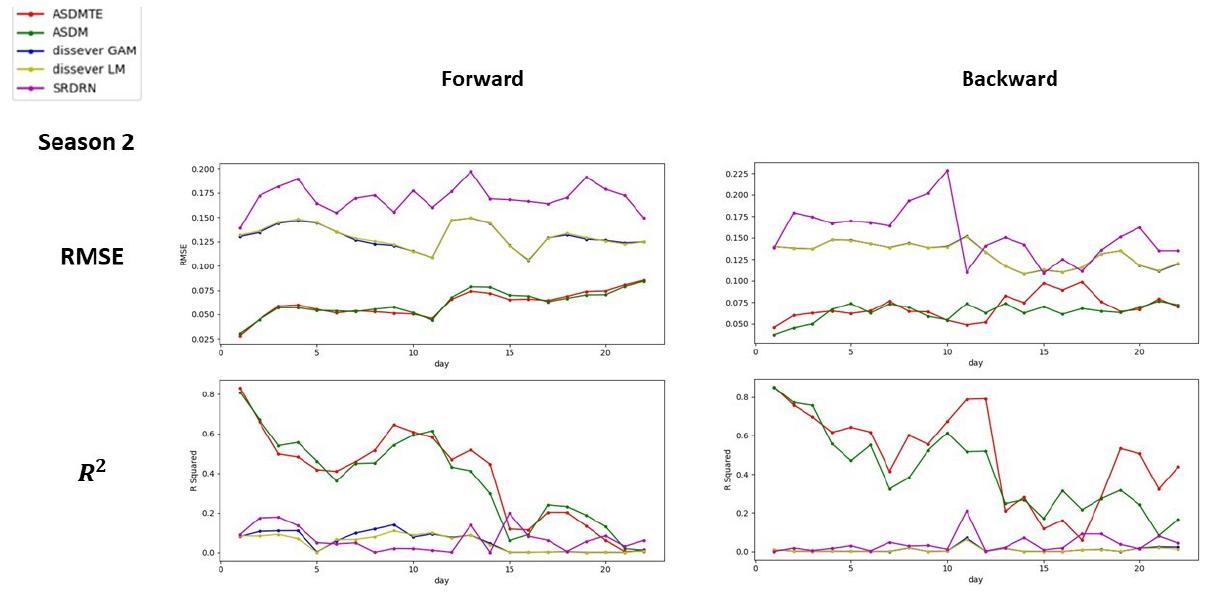
Figure A1. Downscaling performance of ASDM, ASDMTE, SRDRN, dissever GAM and dissever LM in Season 1. Please refer to Figure 4 and Section 2.2.3 for the definition of Season 1.